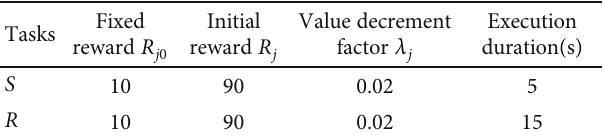
Table 3: Simulation parameters of